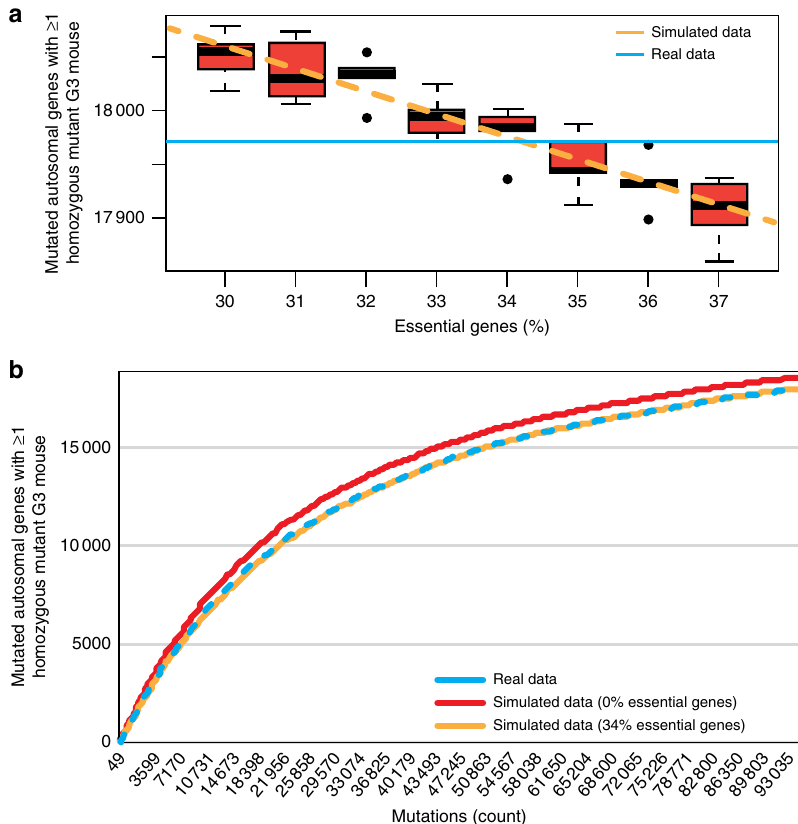
Fig. 3 Determination of the percentage of essential genes by comparison of real and simulated lethality data. a Boxplot of simulated data showing the number of genes carrying any type of mutation for which at least one homozygous mutant G3 mouse existed, for varying percentages of essential genes. For each essential gene percentage, sampling was performed fi ve times and linear regression was used to fi t all the sampled data as a function of essential gene percentage. Red box represents interquartile range, and whiskers extend to the most extreme data point which is no more than 1.5 times the interquartile range; thick black line represents median. Blue line indicates the true number of genes carrying any type of mutation for which at least one HOM mouse existed. Outliers are shown as individual data points. n = 1,105,575 mutations analyzed. b Cumulative plot of the number of genes carrying any type of non-synonymous coding and potential splicing mutation for which at least one homozygous mutant G3 mouse existed vs. number of mutations using real data (blue) and simulated data, assuming essential gene percentages of 0% (red) or 34% (yellow). All fi ve simulations were averaged for plotting